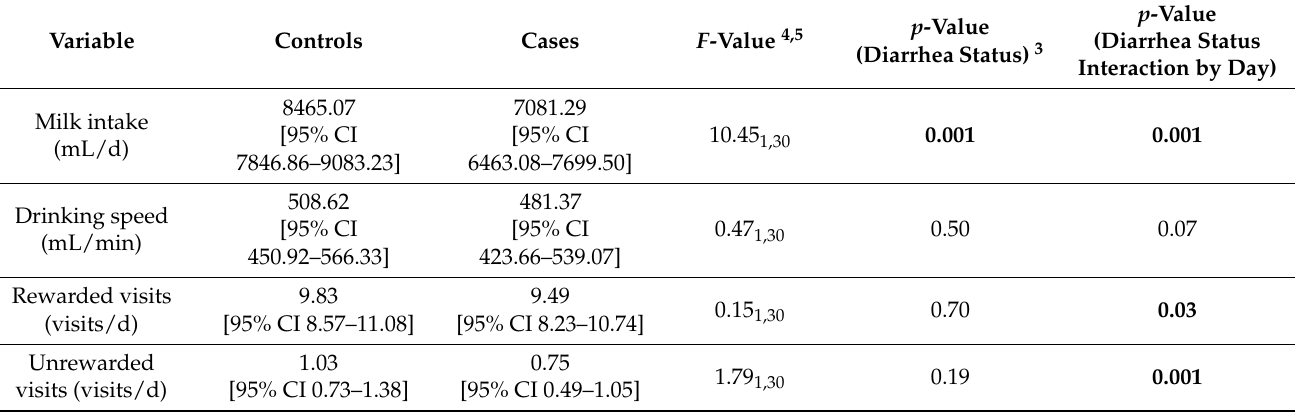
Table 2. The association of diarrhea status (healthy or diarrhea) with feeding behaviors of dairy calves ( n = 31 matched pairs 1 ) in the 3 days before and the 5 days after diarrhea diagnosis. Feeding behaviors (average drinking speed, total milk consumption, number of rewarded and unrewarded visits 2 ) were recorded by an automated milk feeder from which calves were fed milk replacer ad libitum. Results are reported as least squares means and the 95% confidence interval 3